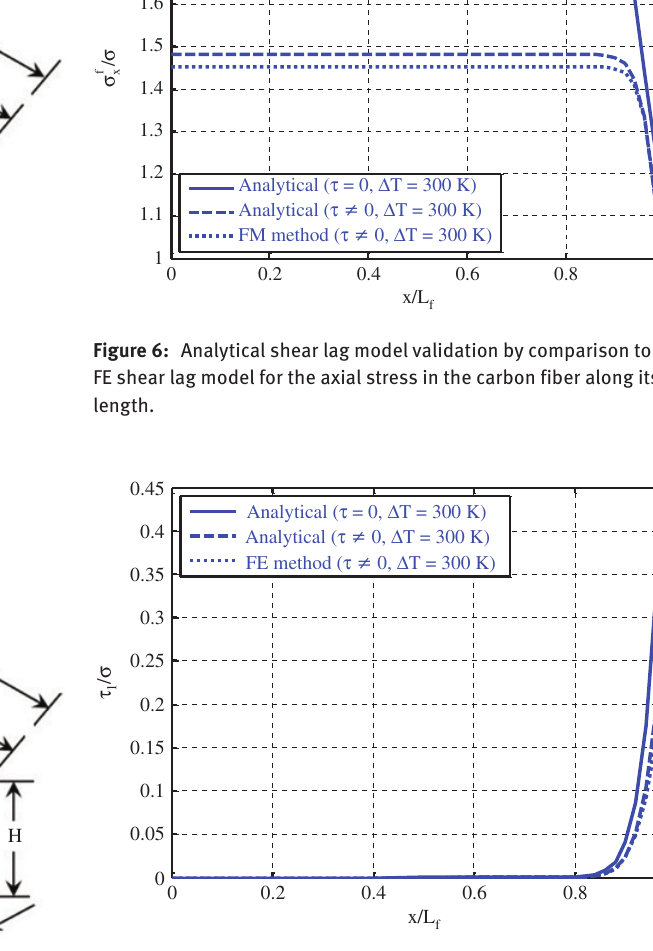
Figure 7: Analytical shear lag model validation by comparison to FE shear lag model for the interfacial shear stress along the carbon fiber